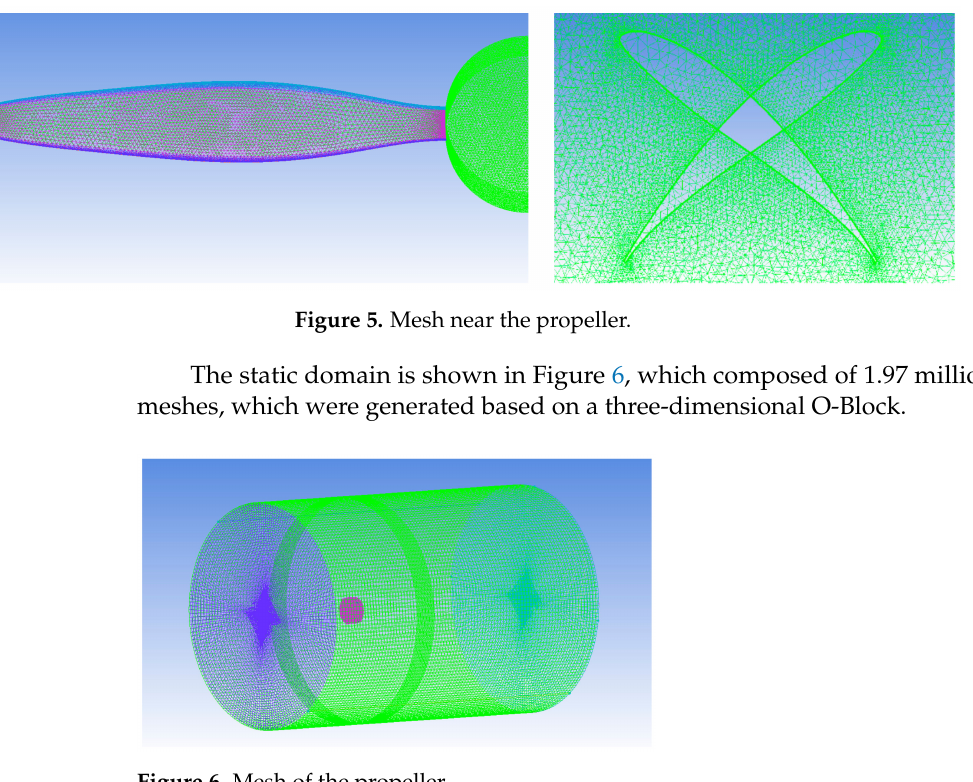
Figure 6. Mesh of the